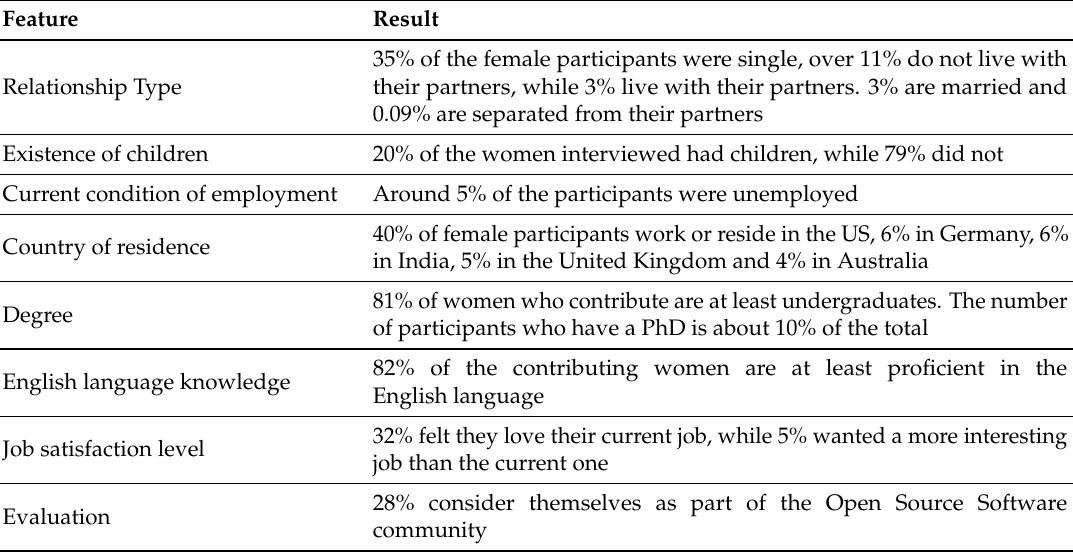
Table 5. Profile of women participating in open source software